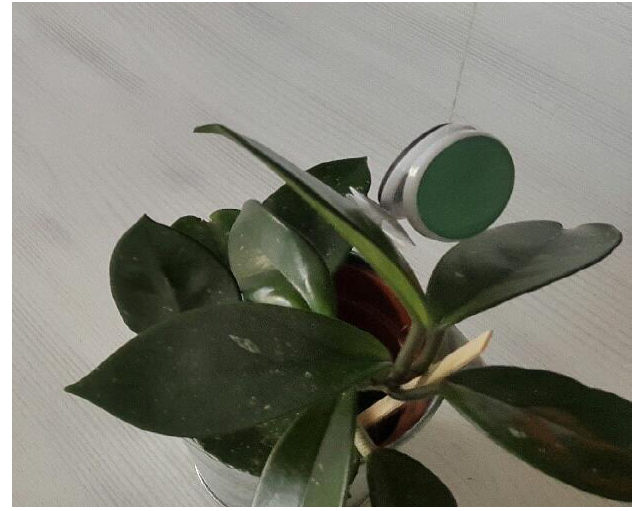
Figure 1. A plant in a magnetic pot, below a magnet attached in the roof as a pendulum